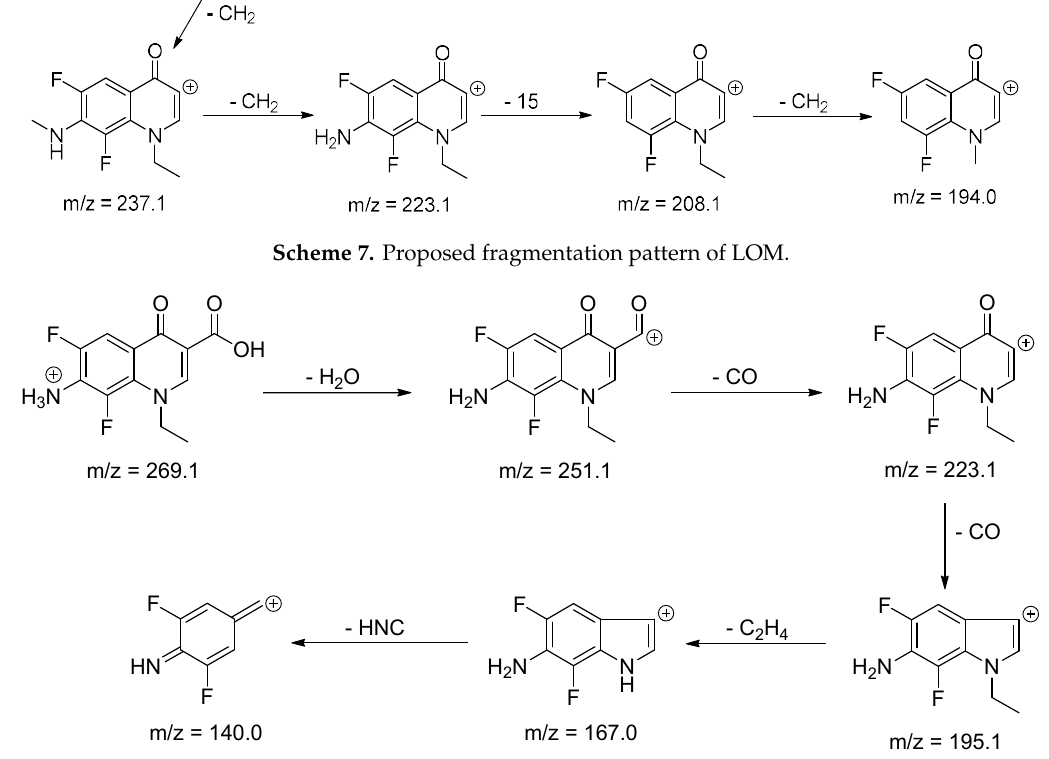
Scheme 8. Proposed fragmentation pattern of LP-1 .